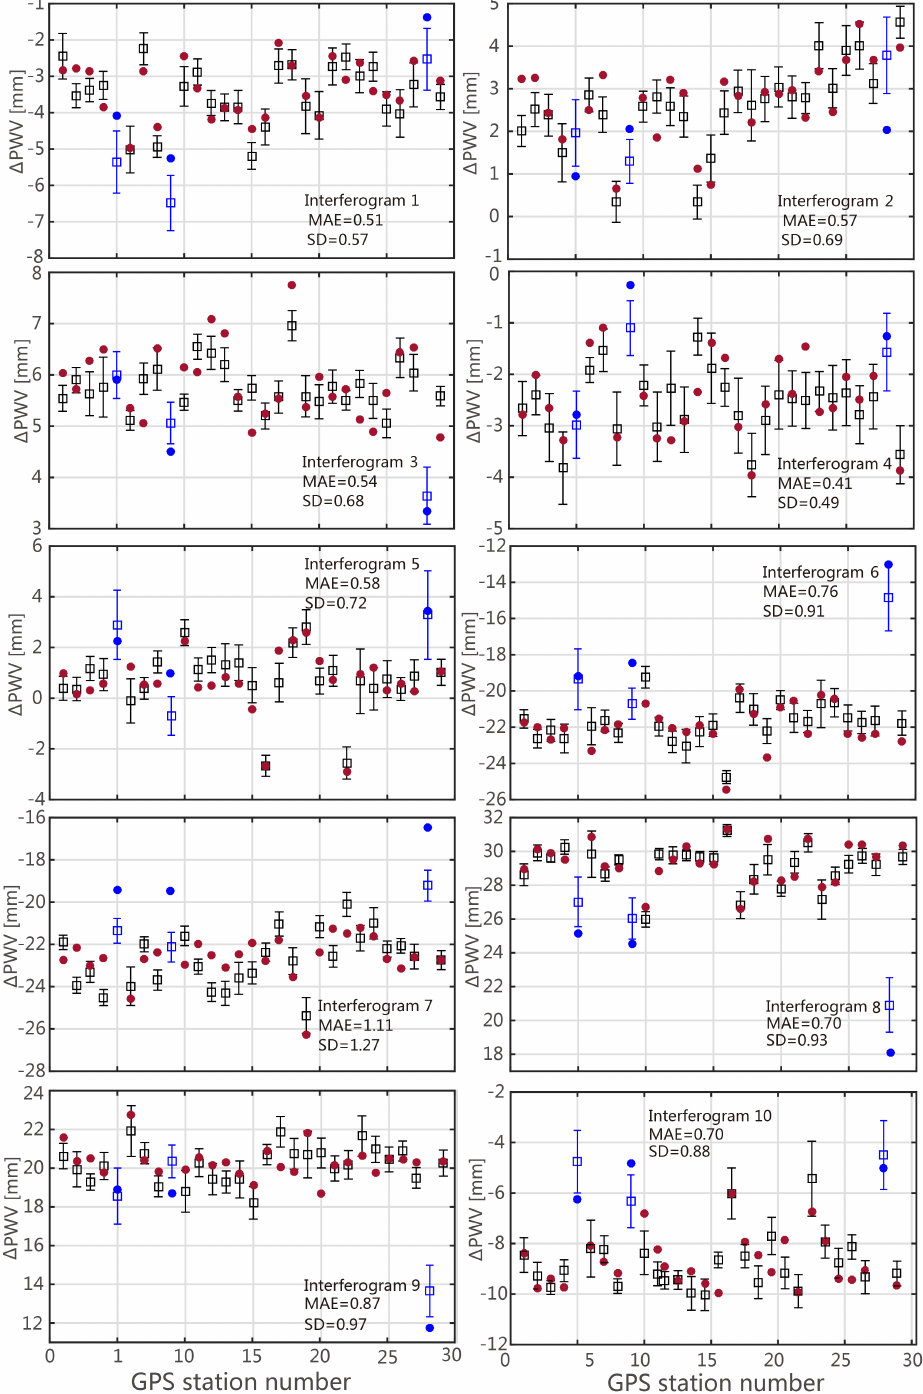
Figure 9. Comparisons of (cid:49) PWV estimates from InSAR (squares) and collocated GPS measurements for each GPS station (circles). The InSAR (cid:49) PWV is estimated from the 10 interferograms in Table 1. The squares indicate (cid:49) PWV estimates from InSAR that are obtained by averaging all pixels falling within the circular area with a radius of 5.4km centred around the station, corresponding to the observational cone above the GPS receiver. The error bars denote standard deviation of the pixel values in the circular area. The blue colour in each plot (from left to right) represents the GPS stations CGDM, ECFS and WLSN